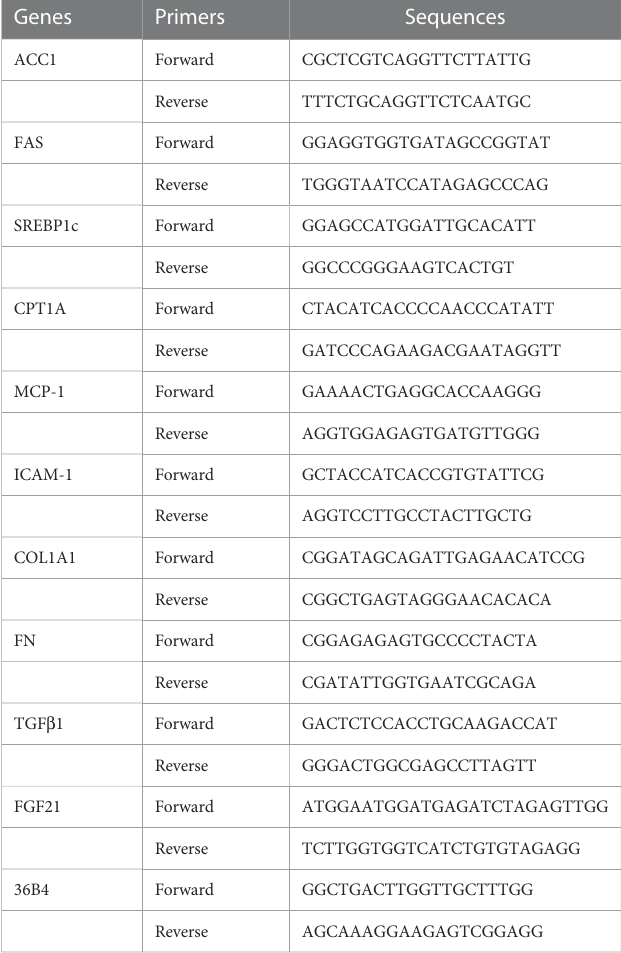
TABLE 1 Primers for